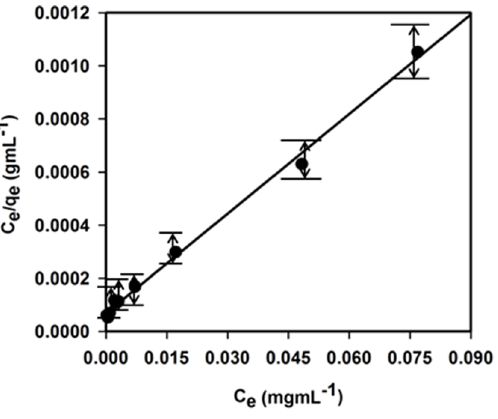
Figure 9. Studied of Langmuir-Adsorption. Langmuir adsorption isotherm model of Co(II) adsorption on 25 mg Ag 2 O 3 -ZnO NCs adsorbentat pH 5.0 and 25 ˚ C. Adsorption experiments were obtained at different concentrations (0–150.0 mgL 2 1 ) of under static conditions.